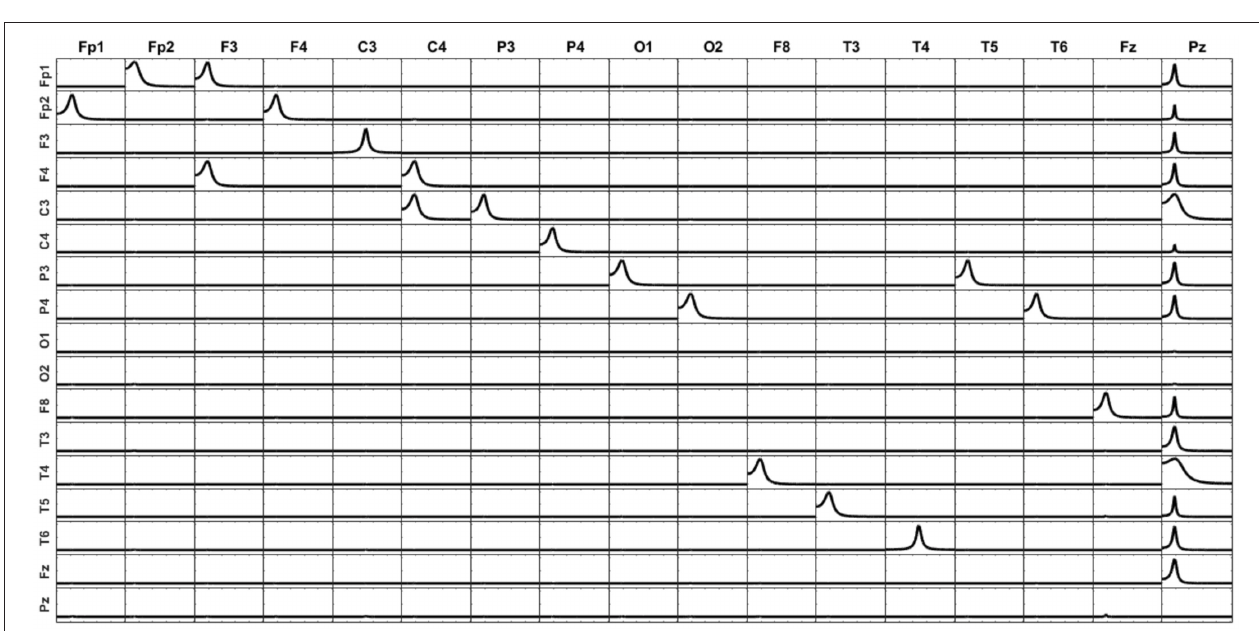
FIGURE 9 | iCOH of the 17-point sources obtained by removing F7 and adding a new voxel (Pz) which was not in the original system. All the unexplained causality appears as artifacts in Pz.